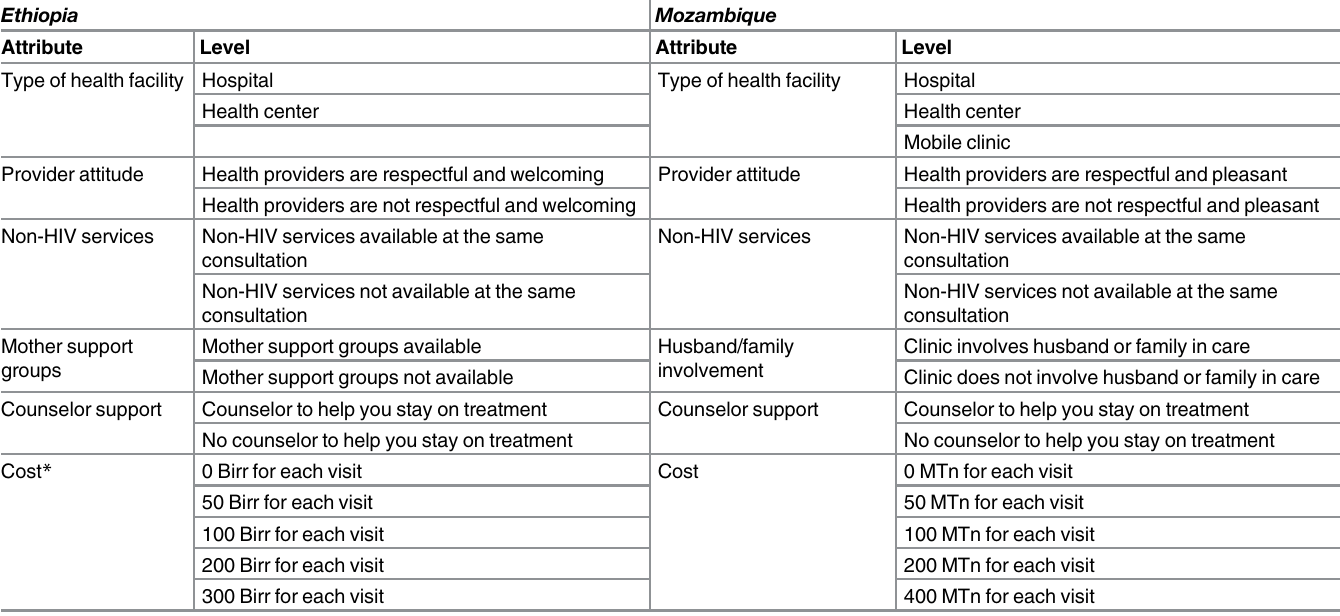
Table 2. Attributes and levels of health services used in discrete choice